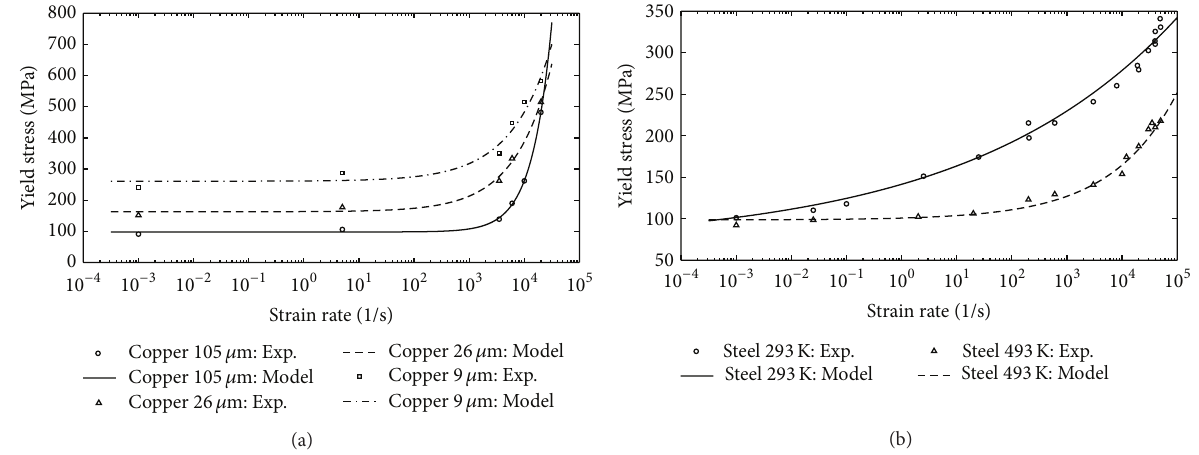
Figure 5: Yield stress fitting by the Cowper-Symonds model: (a) copper and (b) steel.